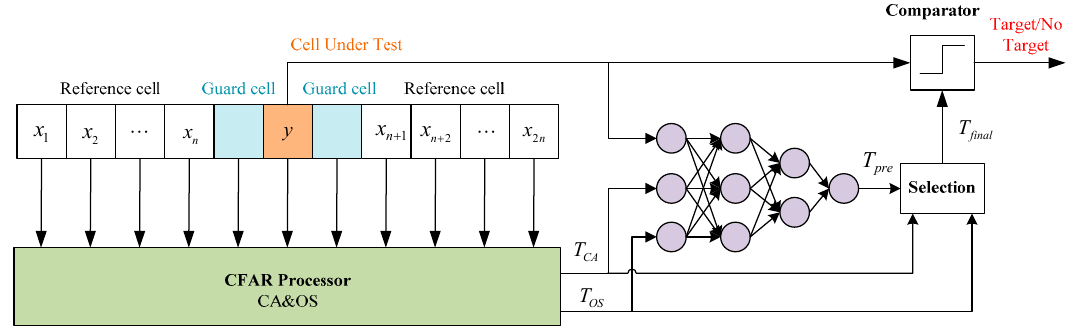
Figure 8. Design of ANN in switching CA/OS CFAR .